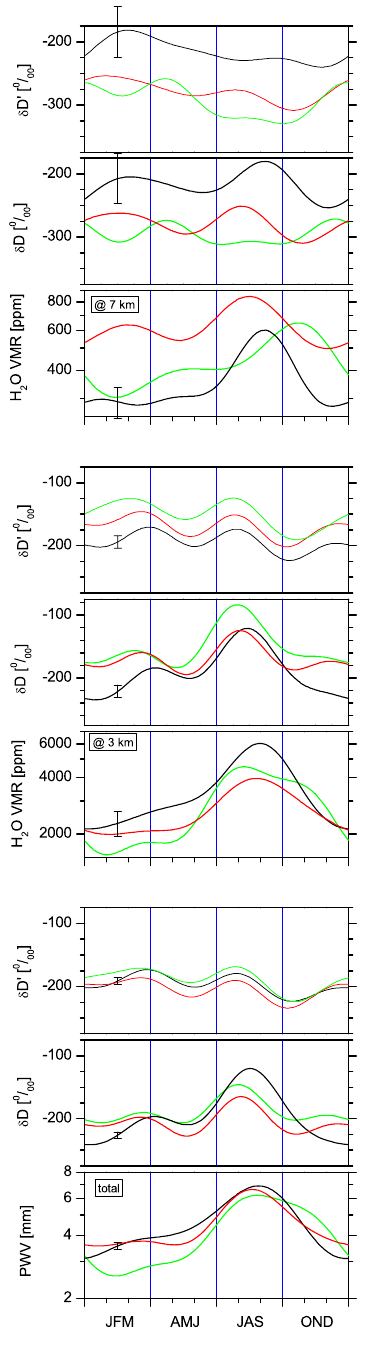
Fig. 9. Same as Fig. 8, but for the subtropical site of